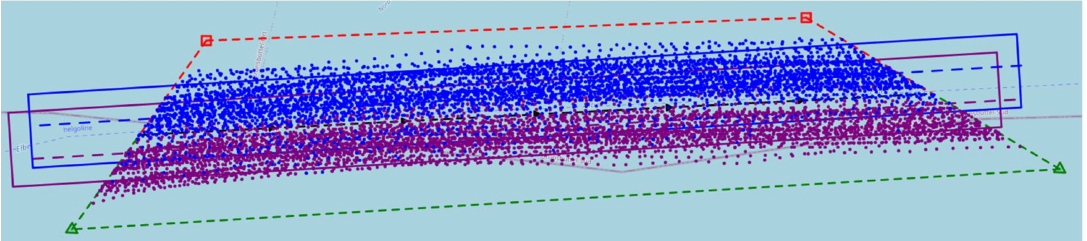
Figure 9. A cell in the Elbe River that is near the lock at